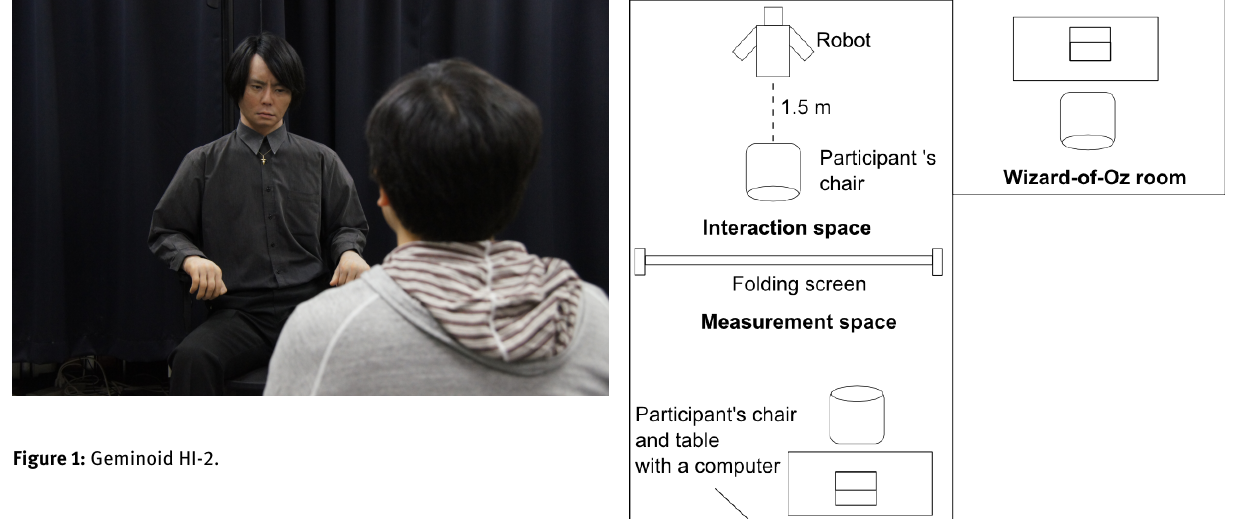
Figure 1: Geminoid HI-2.